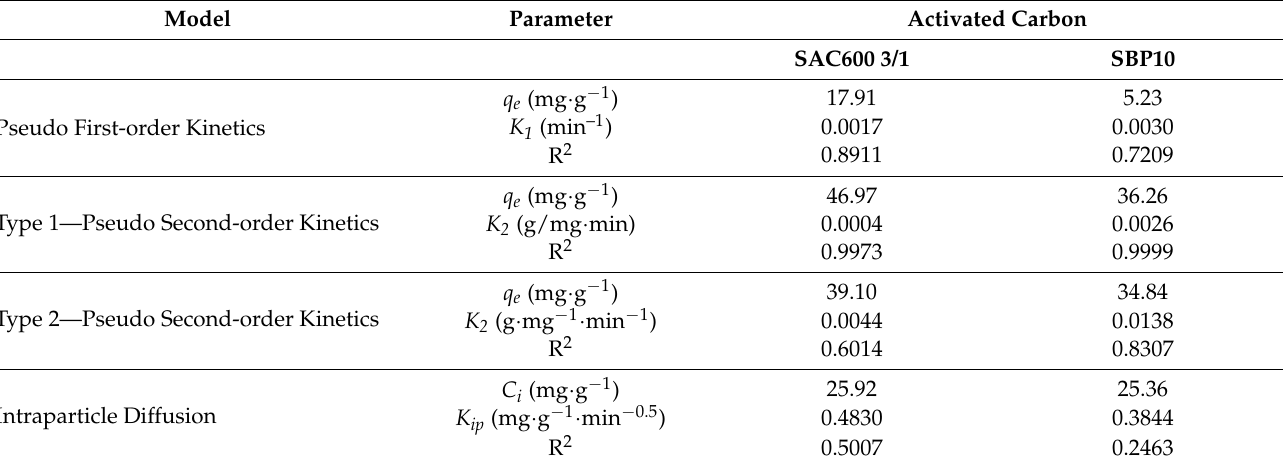
Table 6 summarizes the results obtained from the different models. Table 6. Adsorption kinetics parameters for SAC600 3/1 and